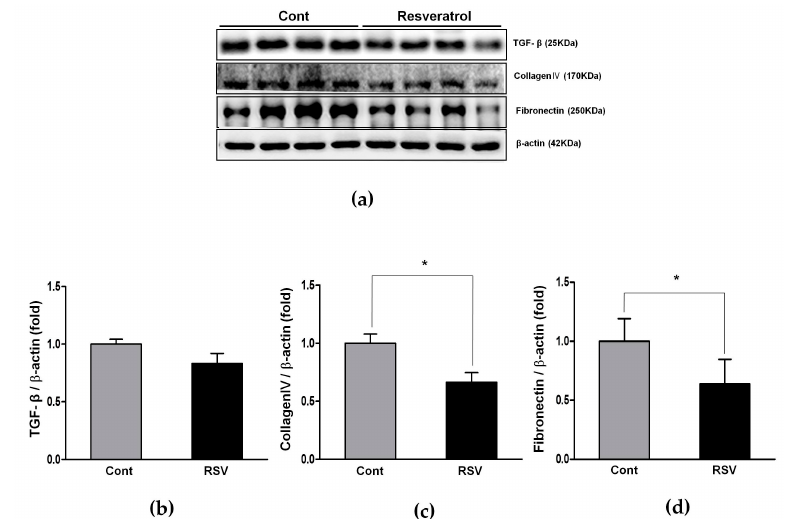
Figure 13. Effects of resveratrol on the TGF- β , collagen IV and fibronectin. ( a ) Representative western blots of TGF- β , collagen IV and fibronectin levels. ( b ) The expression of TGF- β showed a tendency of decrease in the RSV group, compared with the Cont. group, but it was not statistically significant. ( c , d ) The expression of collagen IV and fibronectin was significantly decreased in the RSV group. Quantitative analysis of the results is shown (* p < 0.05).